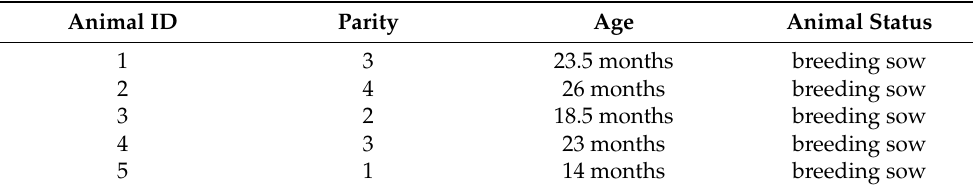
Table 1. Data on the individual animals of the Greek breed tested in this